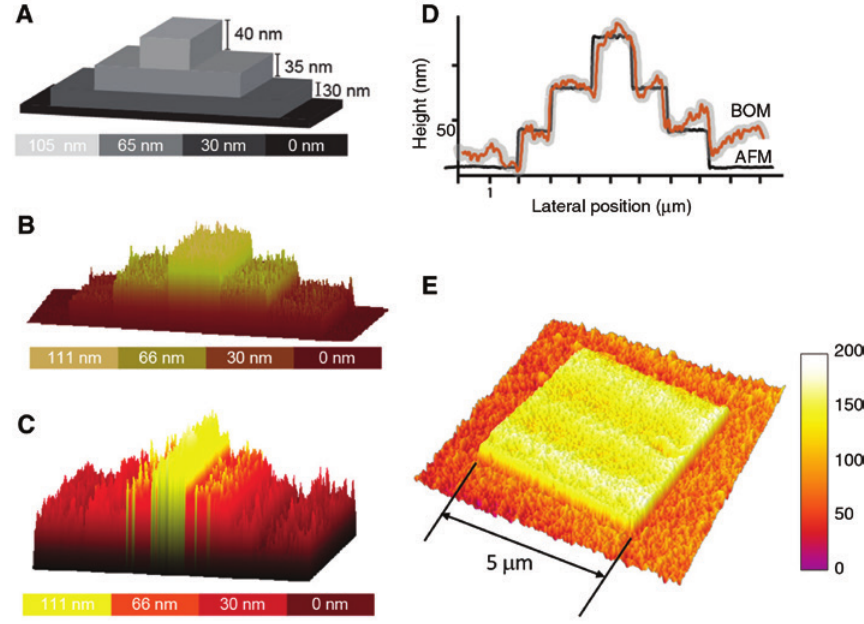
Figure 2: PBM can achieve 30 nm vertical